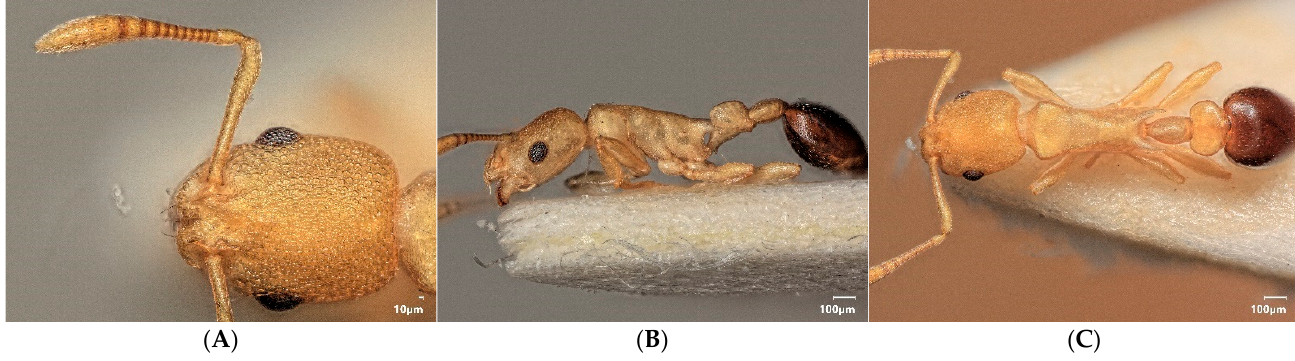
Figure 20. Cardiocondyla goroka n.sp., paratype: head in dorsal view ( A ), lateral view ( B ), dorsal view ( C ).